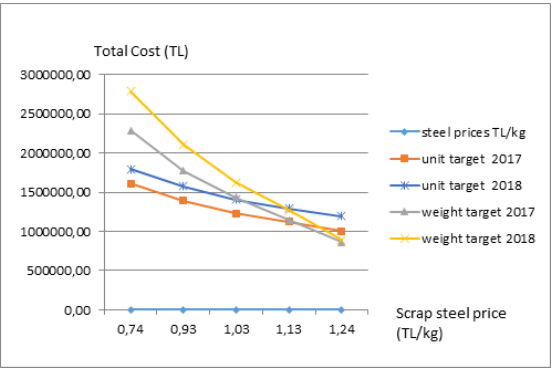
Figure 3. Sensitivity analysis for the scrap steel